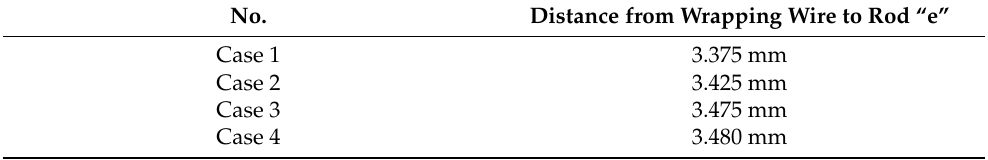
Table 8. Embedding Table 8. Embedding depths.